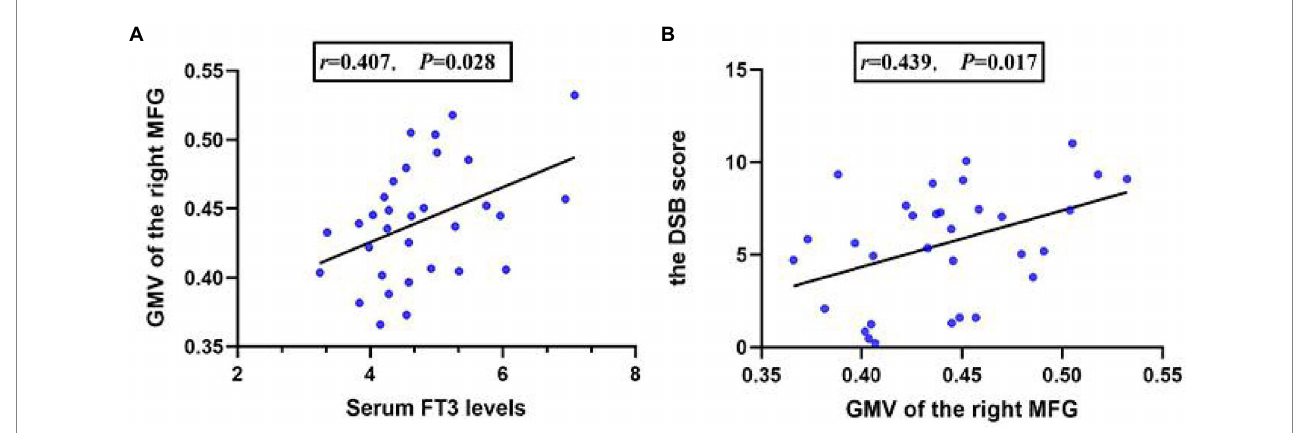
FIGURE 2 The partial correlation between serum FT3 levels and the GMV of the right MFG in comorbid patients (A) , the partial correlation between the GMV of the right MFG, and the DSB score in comorbid patients (B)